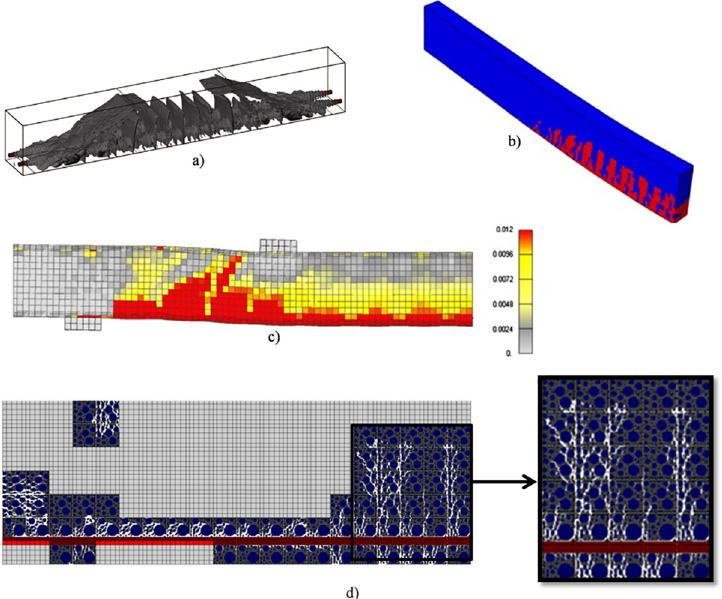
Fig 24. Simulation of debonding or slip of four-point bending RC beam. a) The result given in ref [35]. b) The result given in ref [36]. c) The result given in ref [37]. d) The result in this paper. The first three simulation results didn’t consider the influence of the distribution of coarse aggregates totally; while the last result could present the influence of the distribution of coarse aggregates on crack propagation.